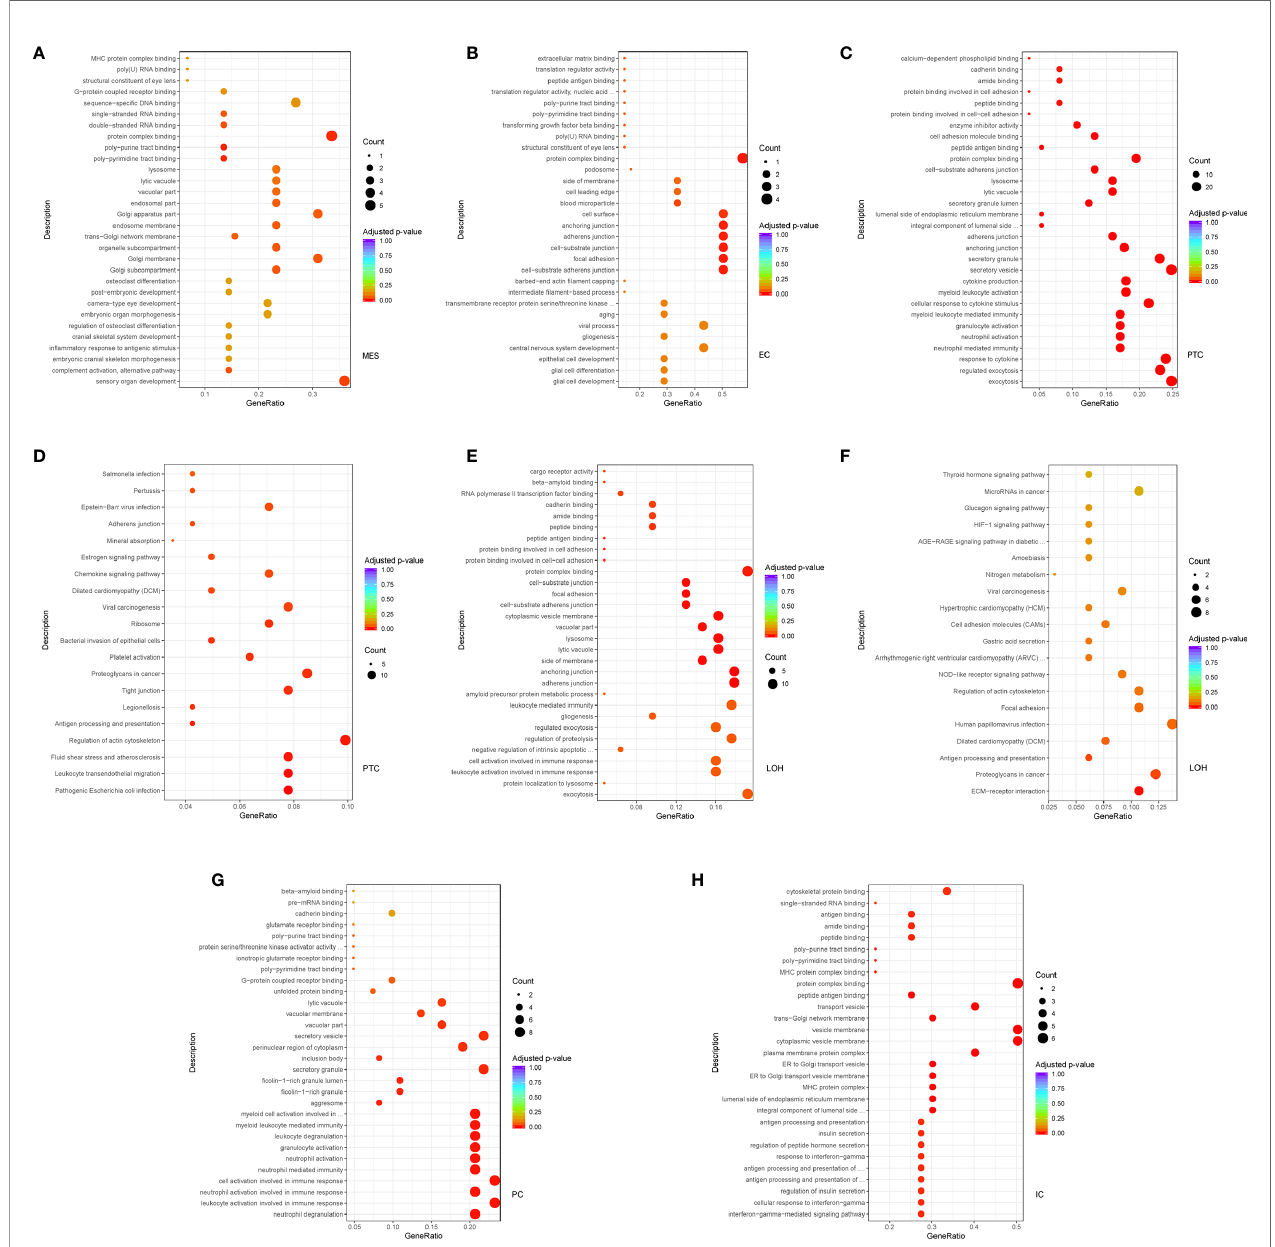
FIGURE 5 | DEGs involved in biological process and intercellular signaling in kidney from IgAN patients with overt proteinuria compared to microproteinuria. (A, B) GO enrichment analysis in mesangial cells and endothelial cells respectively between IgAN patients with overt proteinuria and with microproteinuria. (C – F) GO and KEGG enrichment analysis in proximal tubule cells and loop of Henle cells. (G, H) GO enrichment analysis in principal cells and intercalated cells between IgAN patients with overt proteinuria and with microproteinuria. Abbreviations were as follows: count, number of genes annotated to GO terms or KEGG